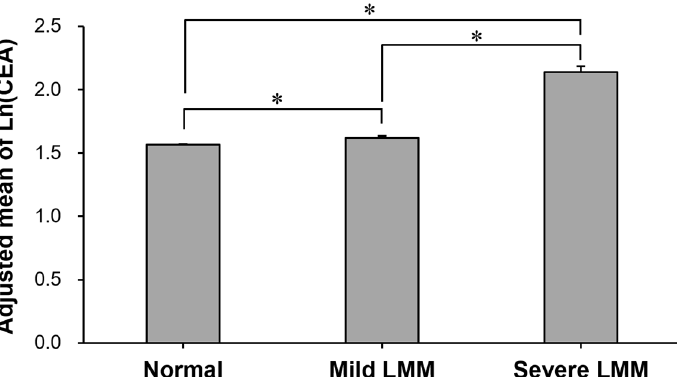
Figure 2. Comparison of adjusted mean of ln(CEA) between normal, mild LMM, and severe LMM groups. Adjusted means ( ± SE) of natural-log-transformed CEA levels in the groups were estimated from ANCOVA after adjustments for age, sex, history of hypertension, history of diabetes, HDL-C, ALT, and CRP. *: Group difference by Bonferroni post hoc p < 0.001. ALT: alanine aminotransferase; CEA: carcinoembryonic antigen; CRP: C-reactive protein; HDL-C: high-density lipoprotein cholesterol; LMM: low muscle mass; SE: standard error.